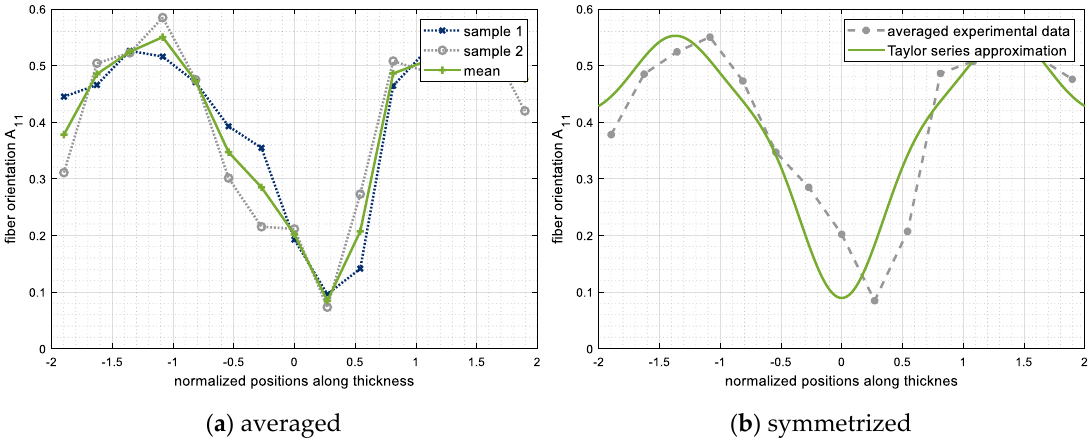
Figure 13. Processing of the fiber orientation results for objective comparison (PP-LGF20 v30).